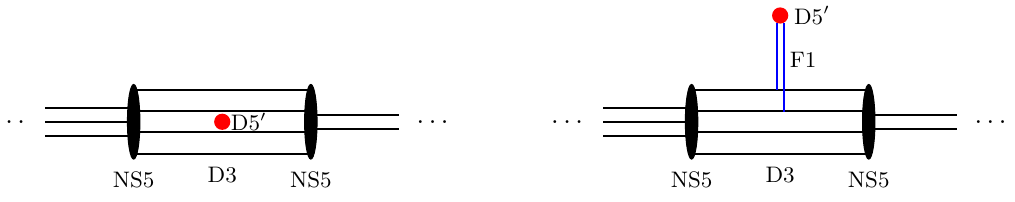
Figure 7. D5 0 -brane realization of a Wilson loop in the antisymmetric representation of rank k at the t th gauge node. The D5 0 extends along the (045678) directions. Moving the D5 0 out of the D3-brane stack across k D3-branes creates k fundamental strings stretched between the D3-branes and the D5 0